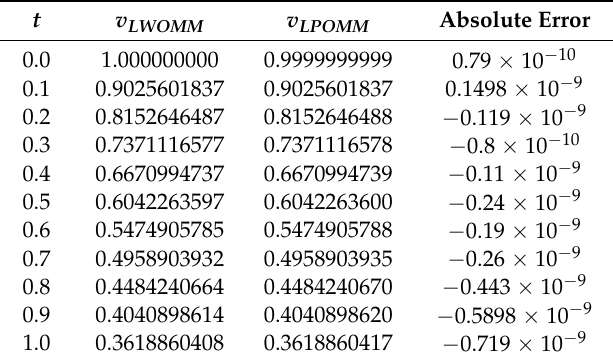
Table 8. Numerical solutions of v ( t ) when α = 0.99 for Example